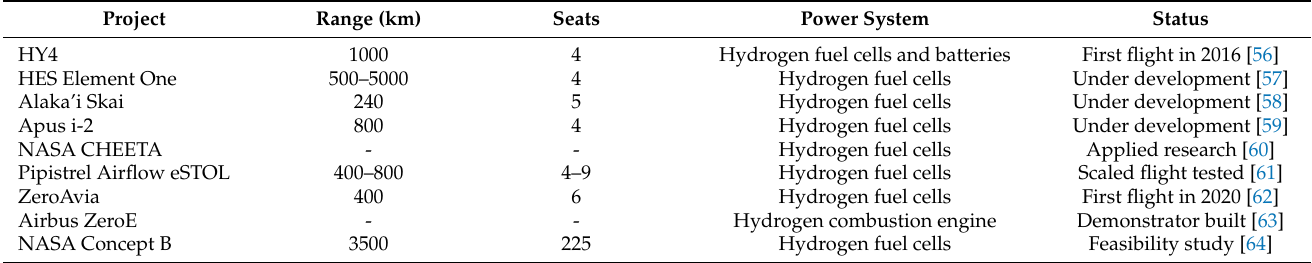
Table 6. Research and industrial projects applying hydrogen technologies.